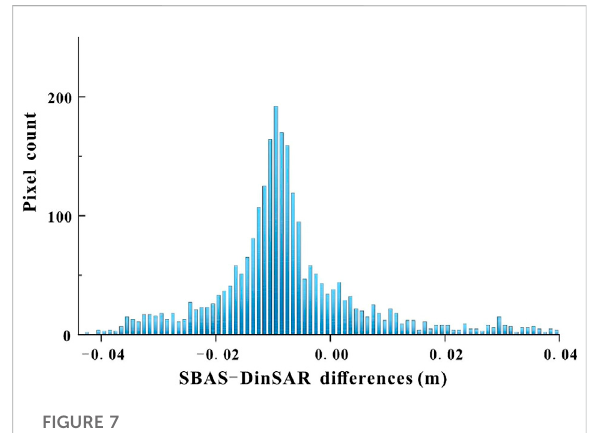
FIGURE 7 Histograms of the SBAS-InSAR and the continuous D-InSAR